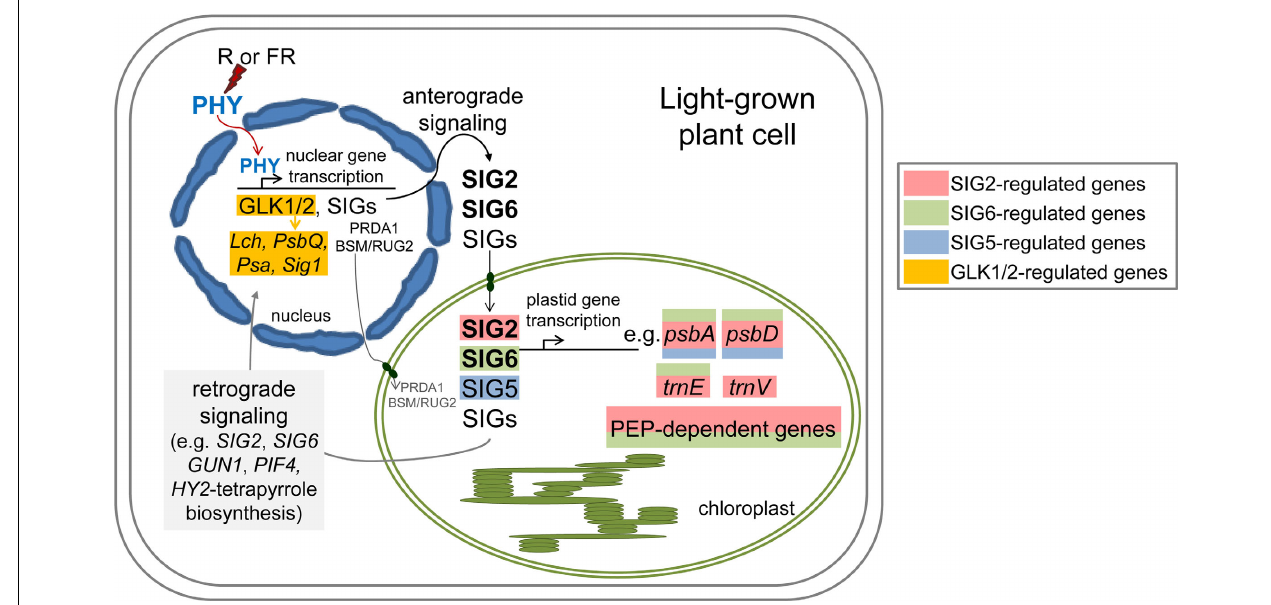
FIGURE 5 | Model of light- and phytochrome-dependent regulation of anterograde signaling between the nucleus and plastid during chloroplast development and photomorphogenesis. PEP, Plastid-encoded plastid RNA polymerase; PHY, phytochrome; R, red; FR, far-red.